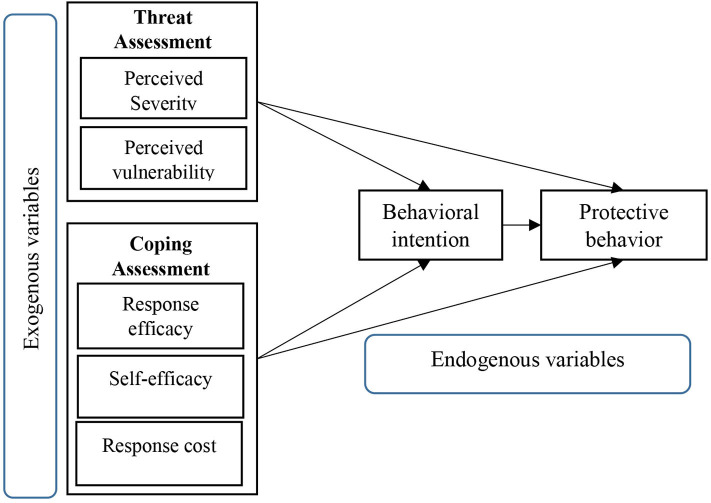
Protection motivation theory (6).